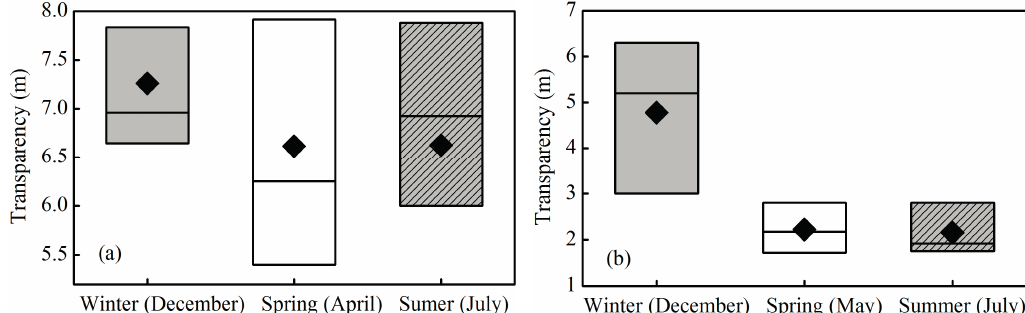
Figure 4. Boxplots of transparency at Daba in the spring, summer and winter in Xin’anjiang Reservoir for long-term observations over the 26-year period (1988 to 2013) ( a ) and short-term observations from 2013 to 2014 ( b ). The box is determined by the 25th and 75th percentiles, and the values of the median (horizontal line) and mean (diamond) are also included.